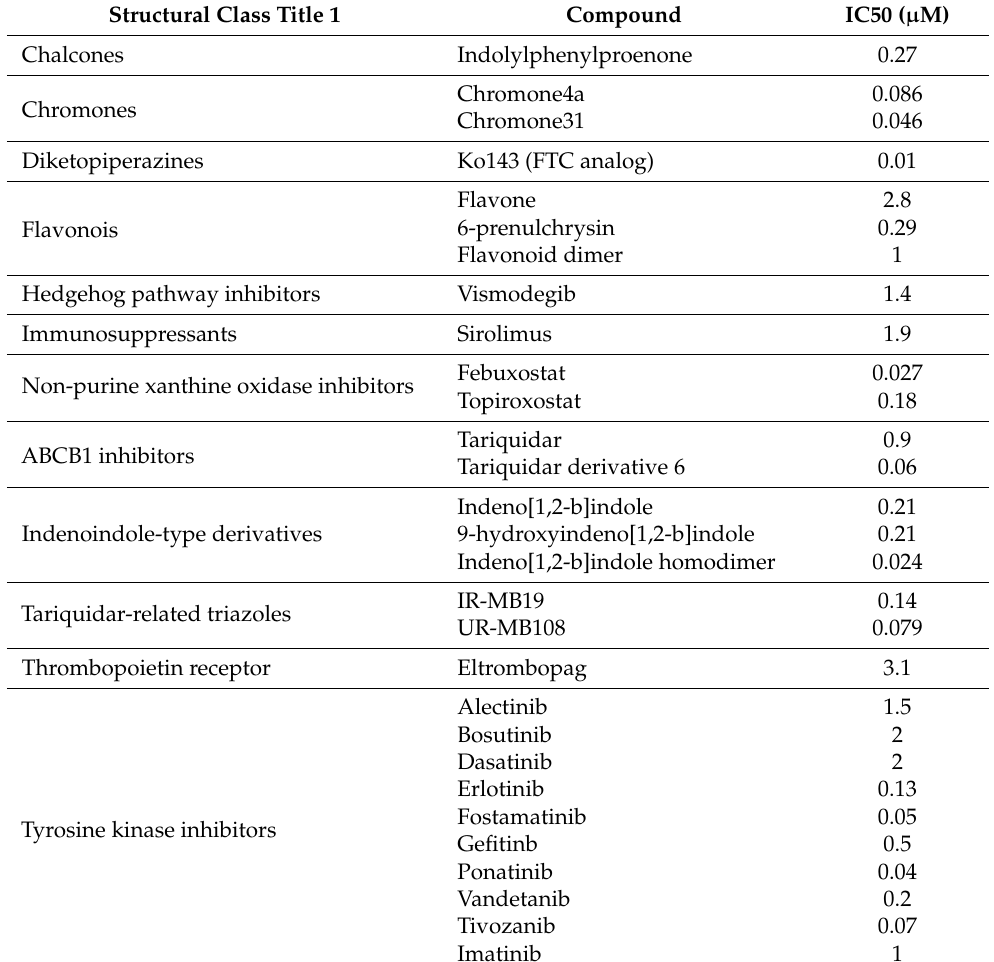
Table 3. Selected list of ABCG2 inhibitors by class of compounds 1